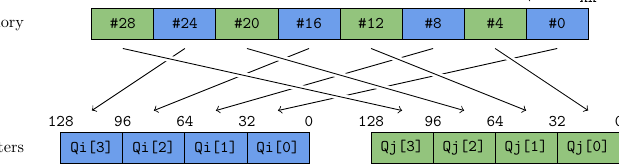
Figure 4 32-bit deinterleaving load at stride